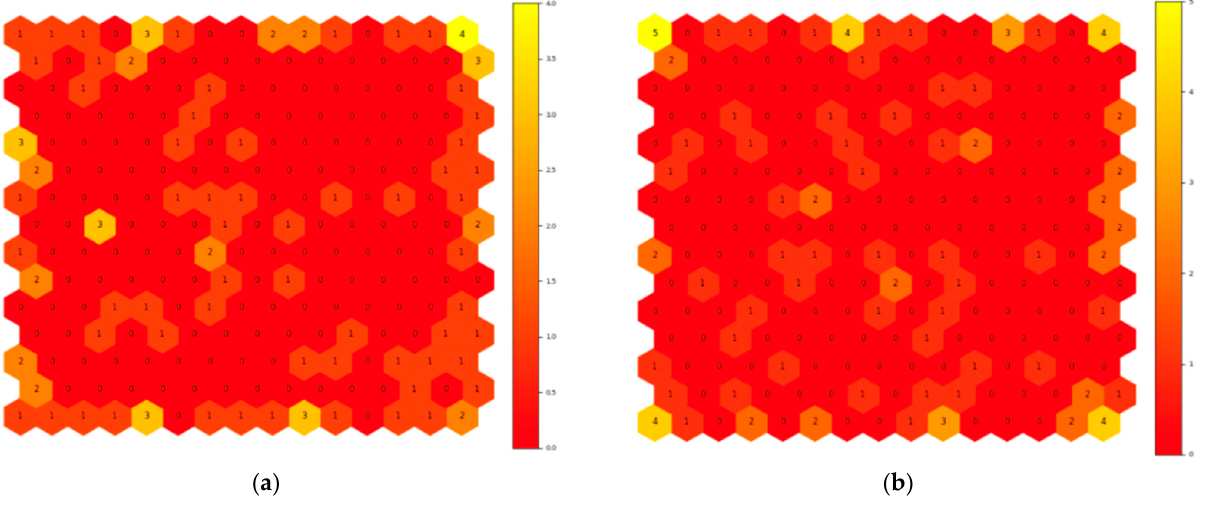
Figure 11. Users’ data points map: ( a ) session number 3; ( b ) session number 5.